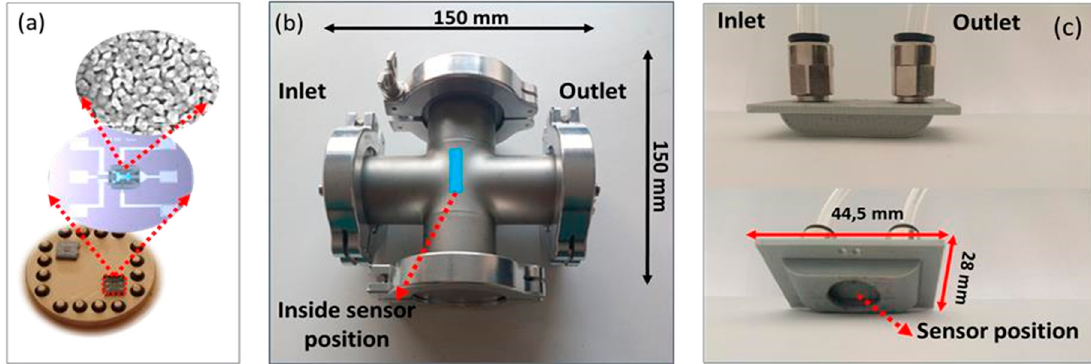
Figure 1. Photographs of: ( a ) SnO 2 sensor; ( b ) cross chamber; ( c ) boat